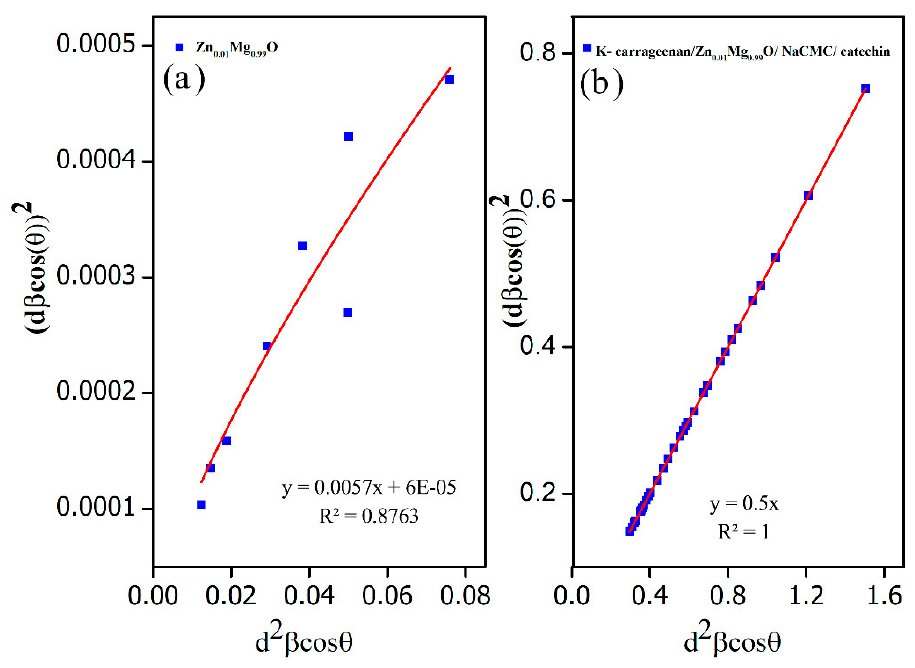
Figure 5. SSP plot for ( a ) Mg 0.99 Zn 0.01 O, ( b ) κ -carrageenan / NaCMC / Mg 0.99 Zn 0.01 O /Catechin .